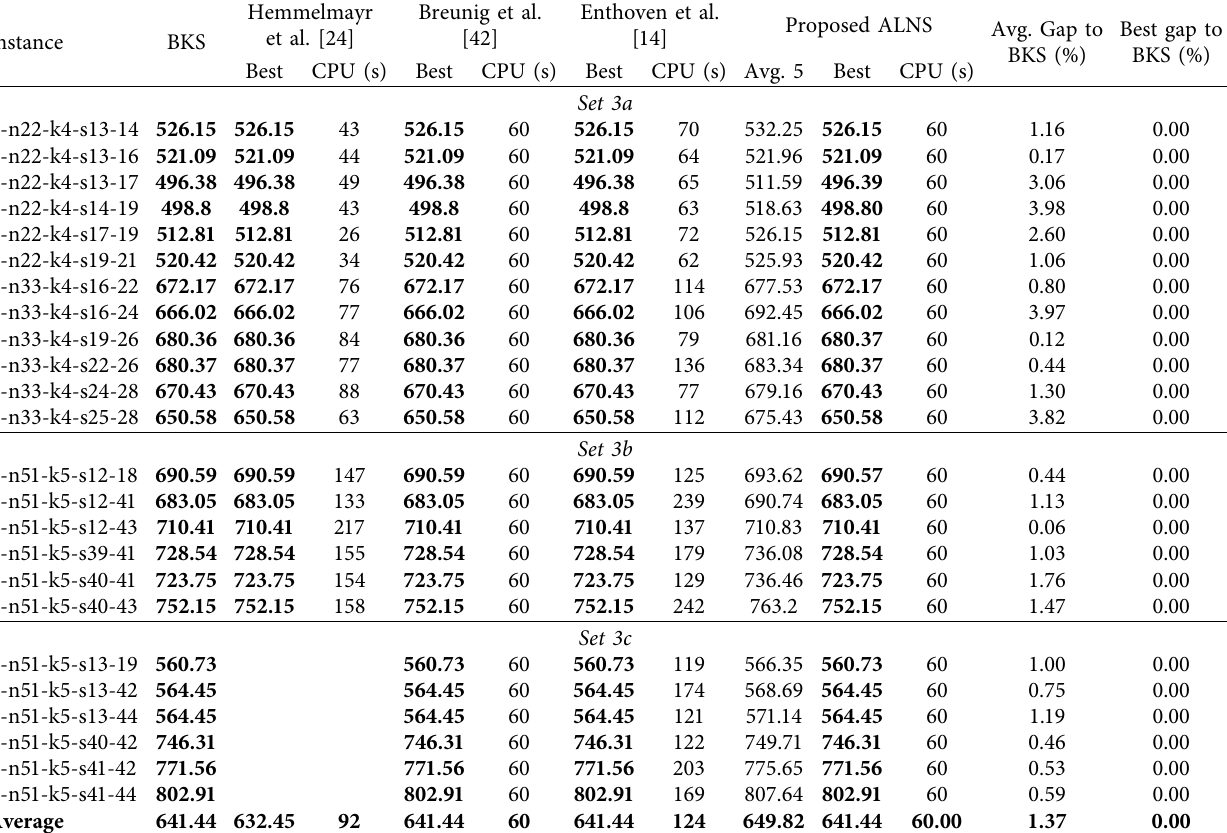
Table 4: Comparative results for solving 2EVRP set 3 instances.